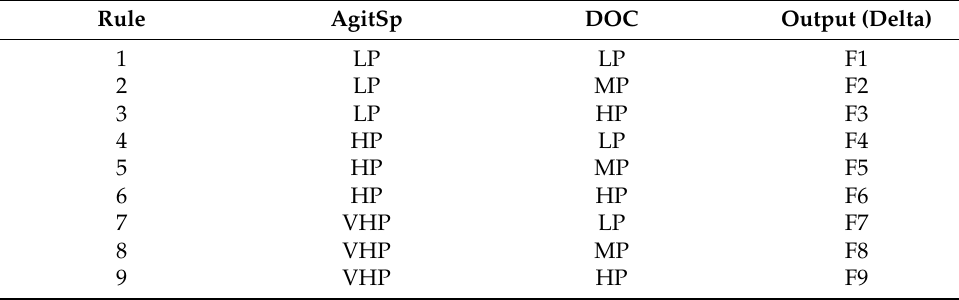
Table 1. Rule table of Delta fuzzy system.